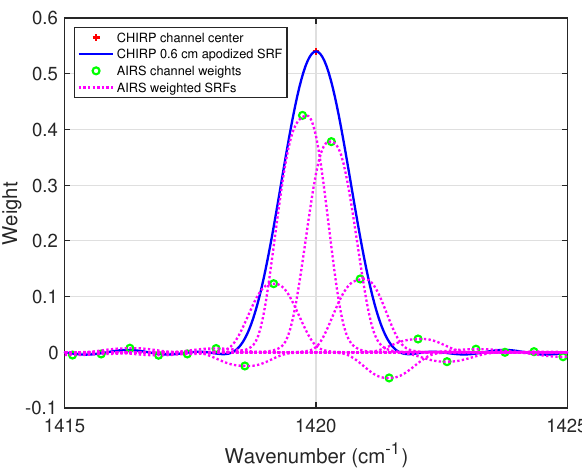
Figure 2. Illustration of how a CHIRP radiance is created from AIRS for a sample mid-wave CHIRP channel centered at 1420 cm − 1 . Note the relatively large number of AIRS channel weights that have very small contributions to the CHIRP